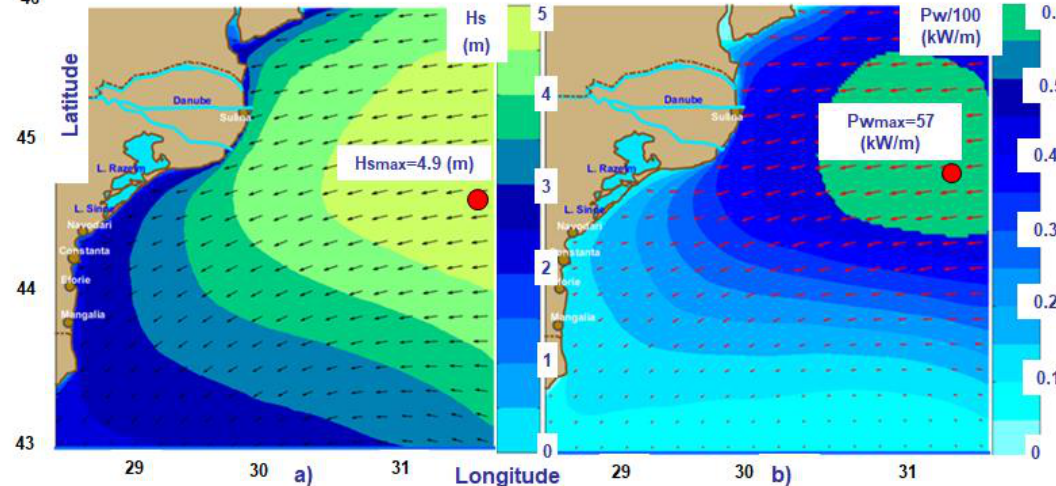
Figure 5. High wave conditions in the western Black Sea (computational domain Sph2), model results corresponding to the time frame 4 February 2017. ( a ) Significant wave height scalar fields and wave vectors (represented by black arrows); ( b ) wave power scalar fields and energy transport vectors (represented by red arrows).